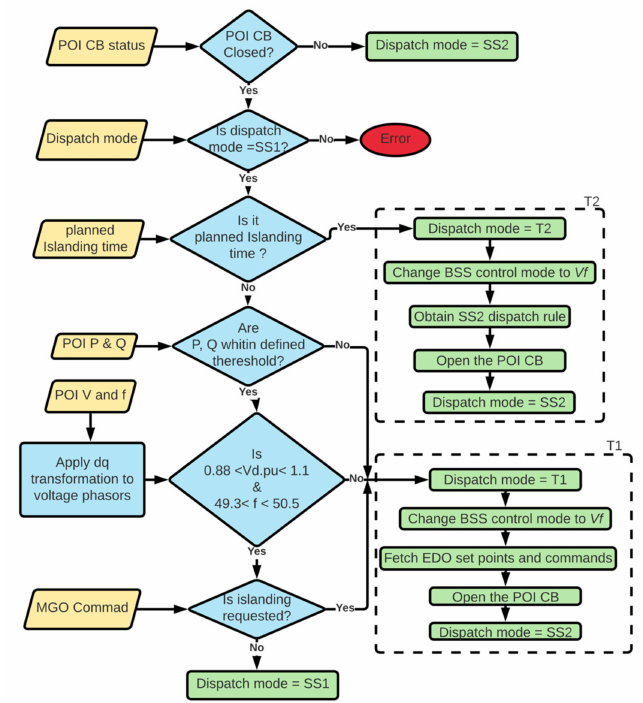
Figure 13. Transition function including T1 and